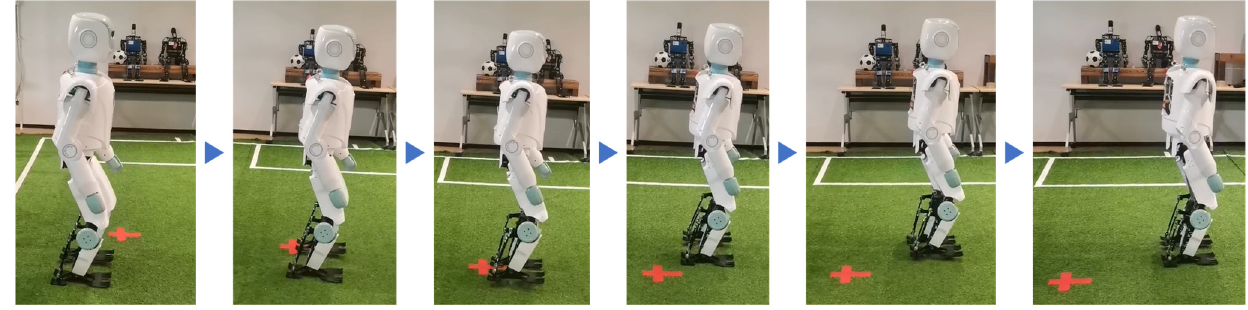
Figure 15. AIRO’s omnidirectional Walking with white linkages.